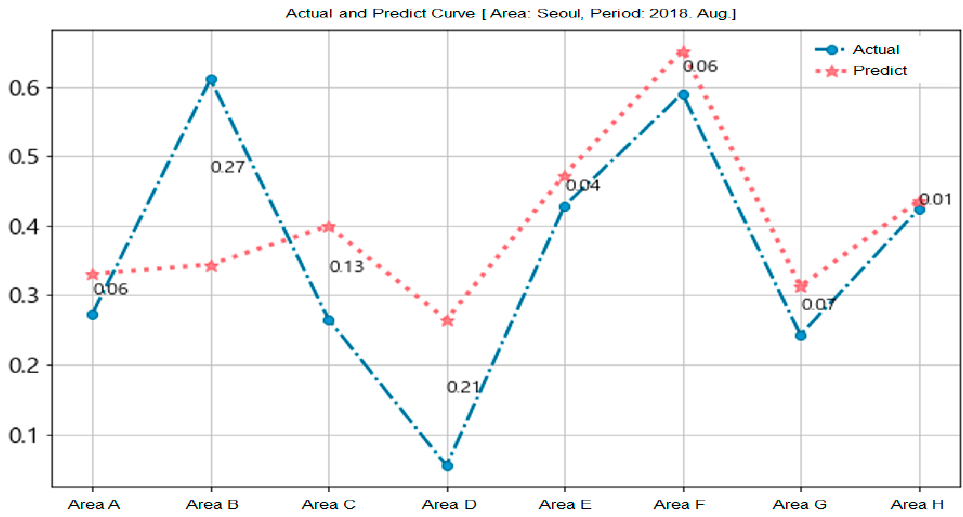
Figure 10. Prediction of epidemic of hepatitis A in Seoul.